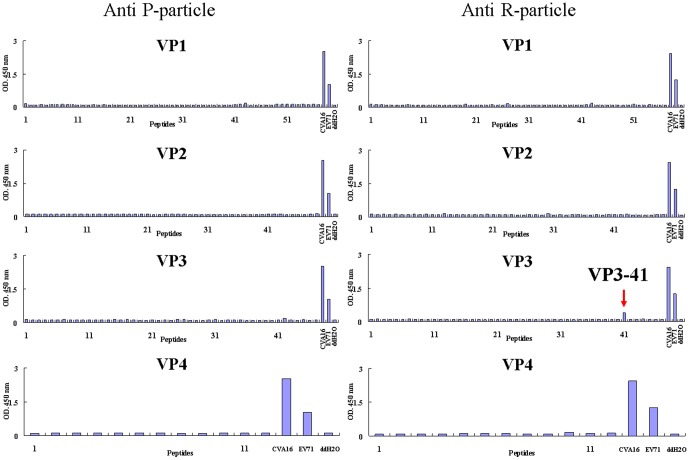
Immunodominant B-cell linear epitope mapping against mouse anti-sera raised against CVA16 formalin-inactivated P-particles (left panel) and formalin-inactivated R-particles (right panel).Peptide-ELISA format was used in covering all VP1, VP2, VP3 and VP4 sequences of CVA16.